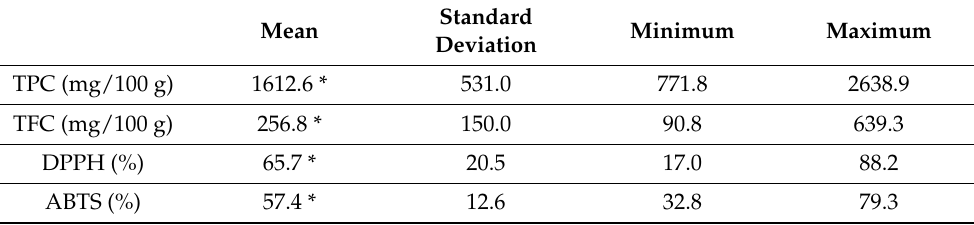
Table 2. Descriptive analysis of TPC, TFC and antioxidant activity expressed as DPPH and